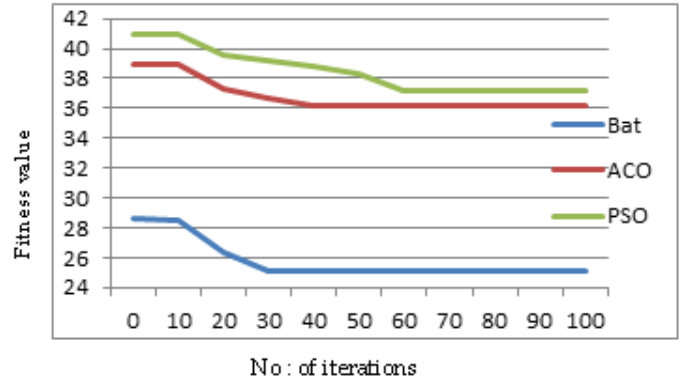
Figure 5. Convergence plot.